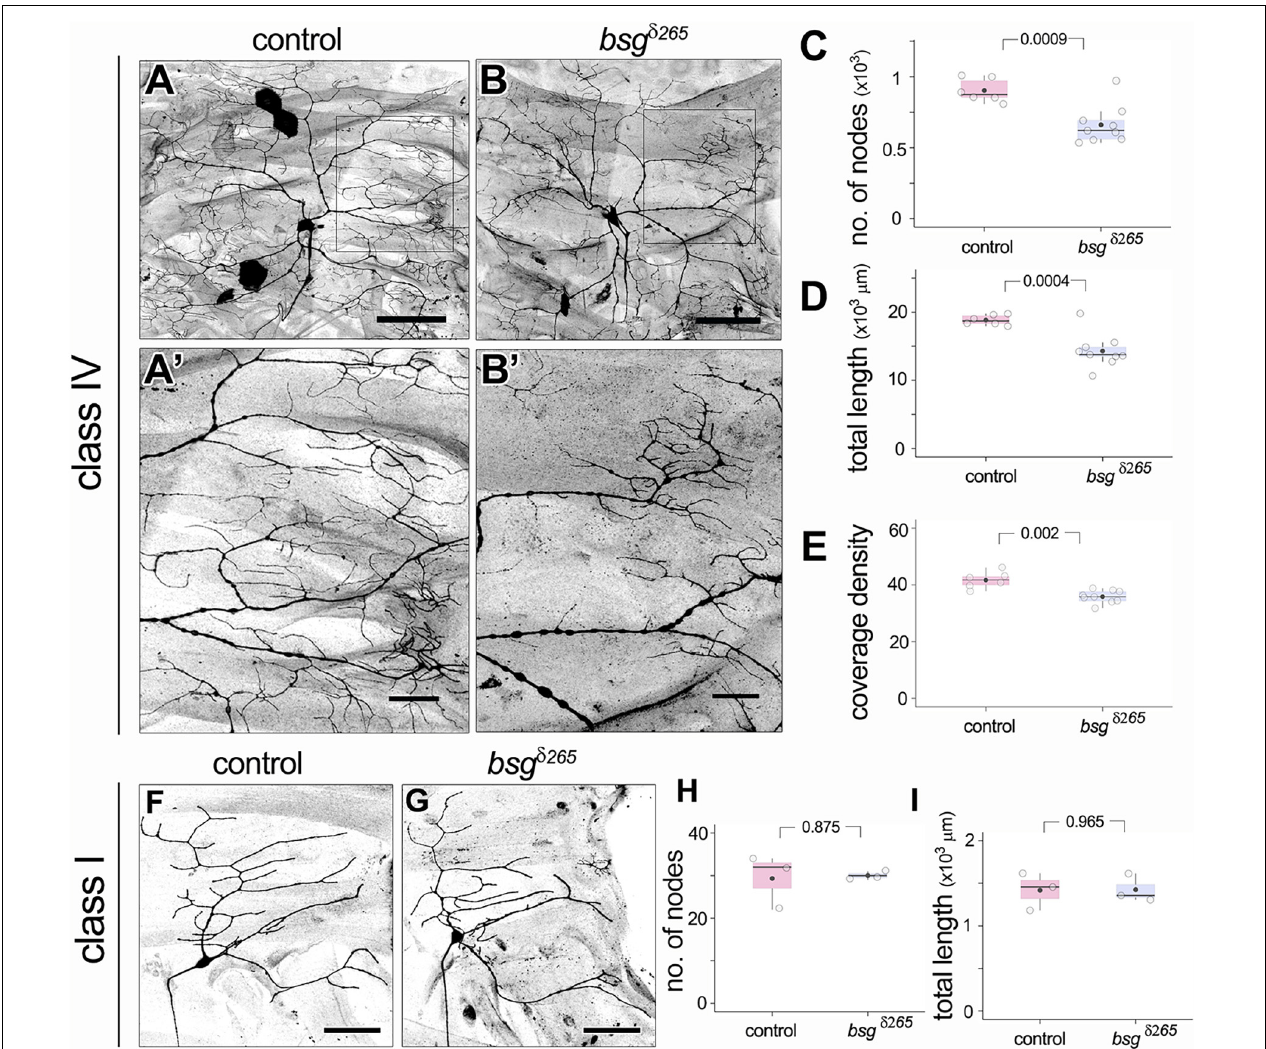
FIGURE 4 | Basigin is required for morphogenesis of dendritic arbors. In contrast to control class IV neurons (A,A’) , bsg δ 265 class IV MARCM clones (B,B’) develop dendritic arbors with significantly fewer branches (C) and reduced total dendrite length (D) at late third instar stage. Insets (A’) and (B’) show magnified views of the boxes marked in (A) and (B) , respectively. Dendrite coverage density (E) of mutant neurons was significantly lower. In contrast, class I da neurons were unaffected by loss of Basigin. Comparison of class I control MARCM clones and bsg δ 265 neurons (F,G) revealed no difference in number of dendrite branch nodes (H) or total dendrite length (I) . Scale bar, 100 µ m in (A,B) , 25 µ m in (A’,B’) and 50 µ m in (F,G) . p values are indicated for Welch’s t